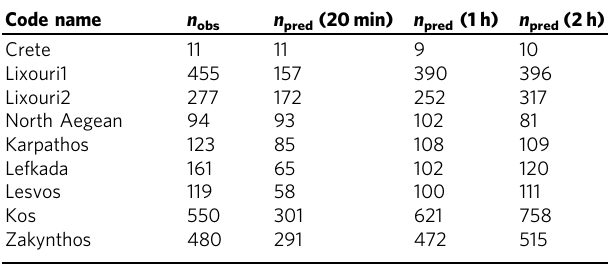
Table 2 The comparison between the observed n obs and predicted n pred ( T )